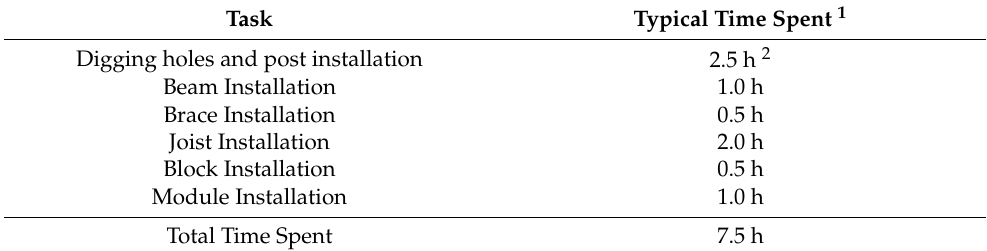
Table 3. Forces and deflections of structural members in the fixed angle rack.